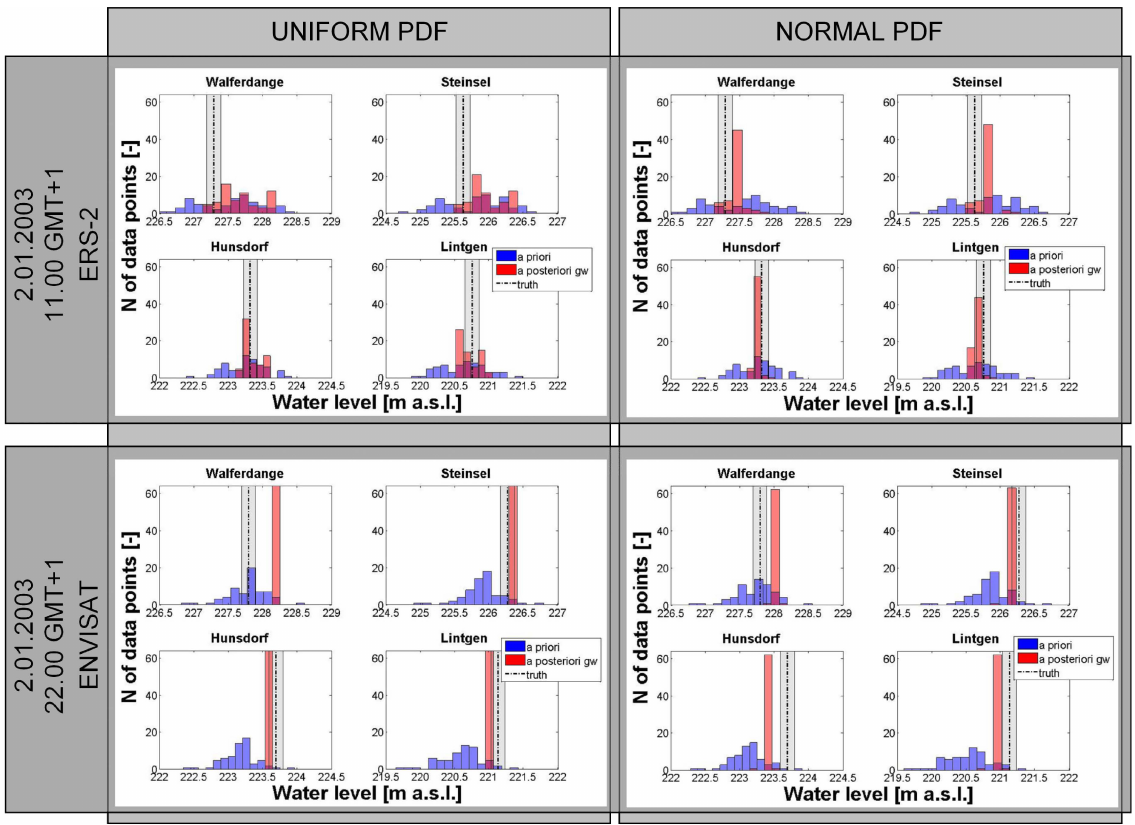
Fig. 8. Histograms of water stages at 4 intermediate cross sections, before and after the resampling step (gw: global weight). Left panels show the application of the uniform pdf on the RSD water levels, right panels the use of the normal pdf on the hydrometric station data. Top graphs refer to the first ERS-2 overpass; bottom ones to the ENVISAT overpass. Gauged level and its presumed uncertainty are also